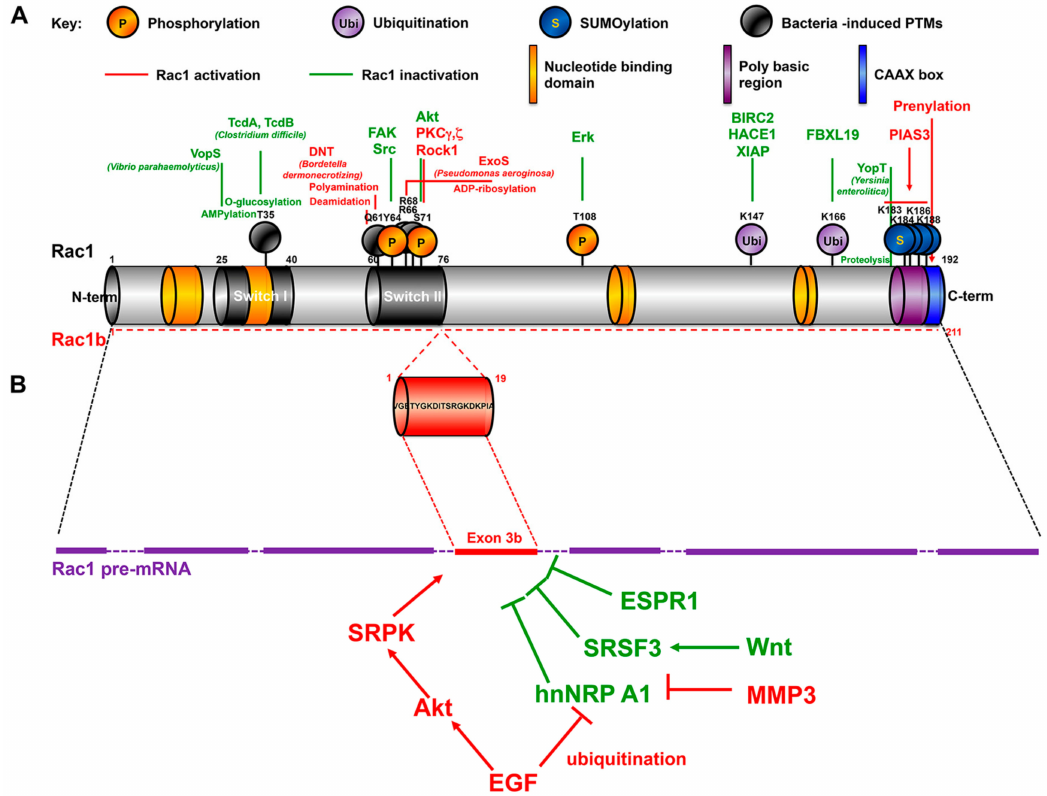
Figure 1. Primary structure of Rac1 and Rac1b splice variant. ( A ) Posttranslational modifications (PTMs) of Rac1. In green are represented PTMs that inactivates Rac1, in Red those that stimulates the GTPase signaling. ( B ) Regulation of Rac1 splicing. For details see the text.